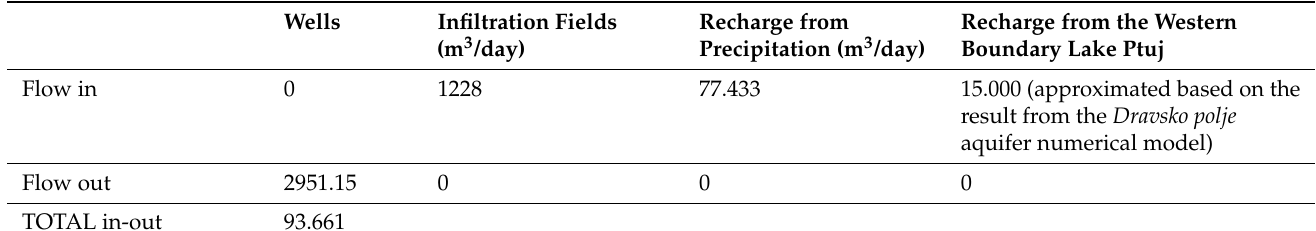
Table 4. Estimated groundwater flow values for the Ptujsko polje